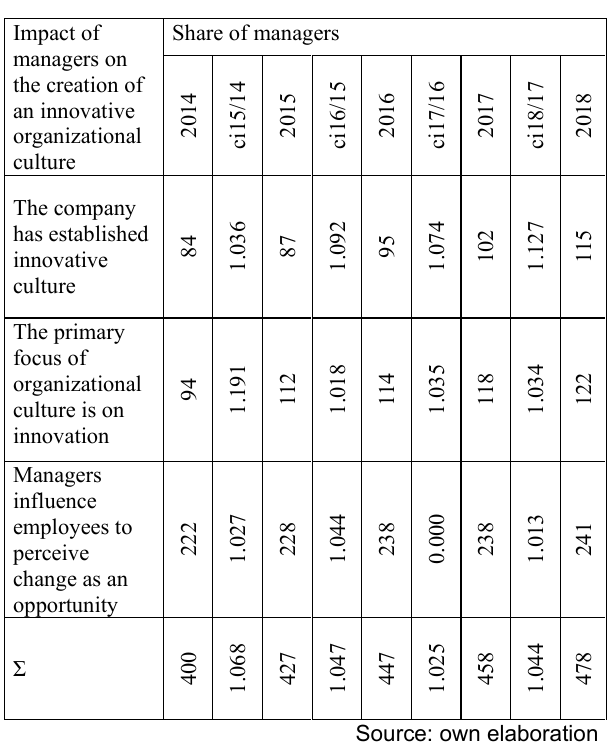
Table 5. Chain Index of Changes - Impact